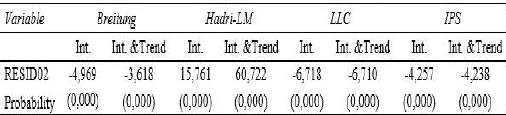
Table 8: Stationarity Test for the Residuals of Long- term Model